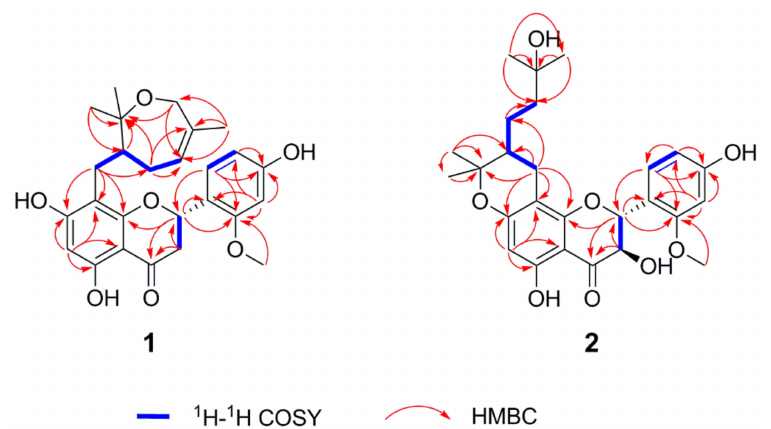
Figure 2. Key 1 H– 1 H COSY ( – ) and HMBC ( → ) correlations of 1 – 2